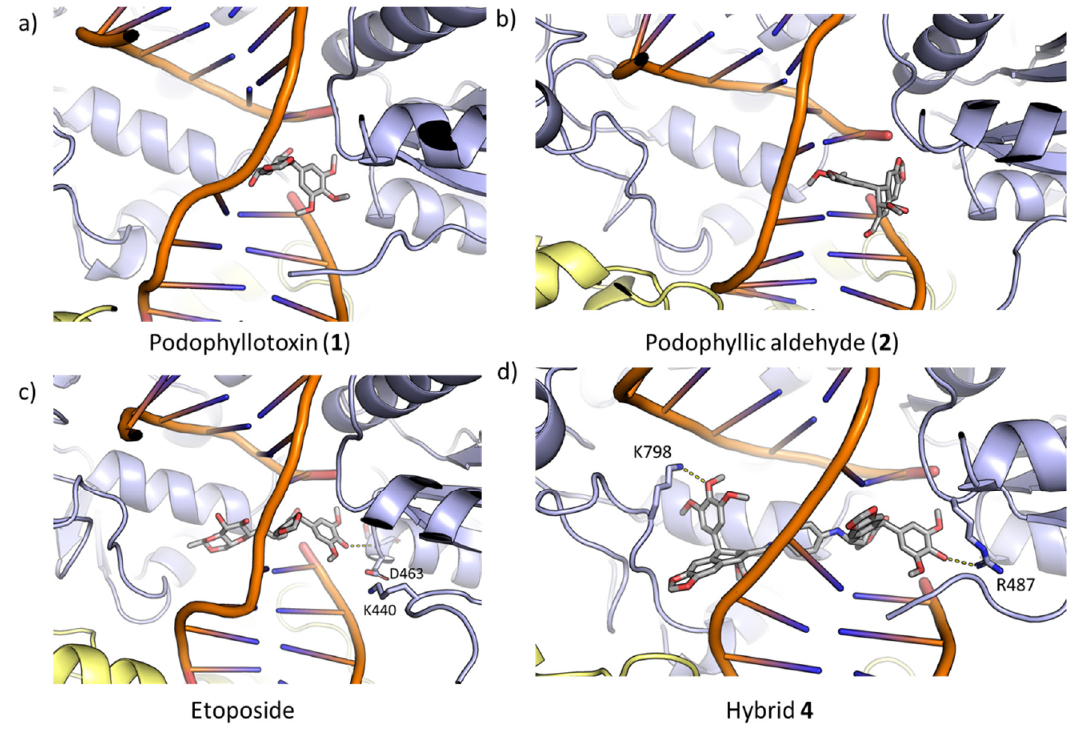
Figure 7. Docking complexes of compounds at end of the DNA breakdown. ( a ) podophyllotoxin ( 1 ), ( b ) podophyllic aldehyde ( 2 ), ( c ) etoposide and ( d ) hybrid 4 . The inhibitors, and those residues that interact with them via hydrogen bonds, are shown atomistically. The two subunits of topo-II are shown in yellow and purple, respectively.